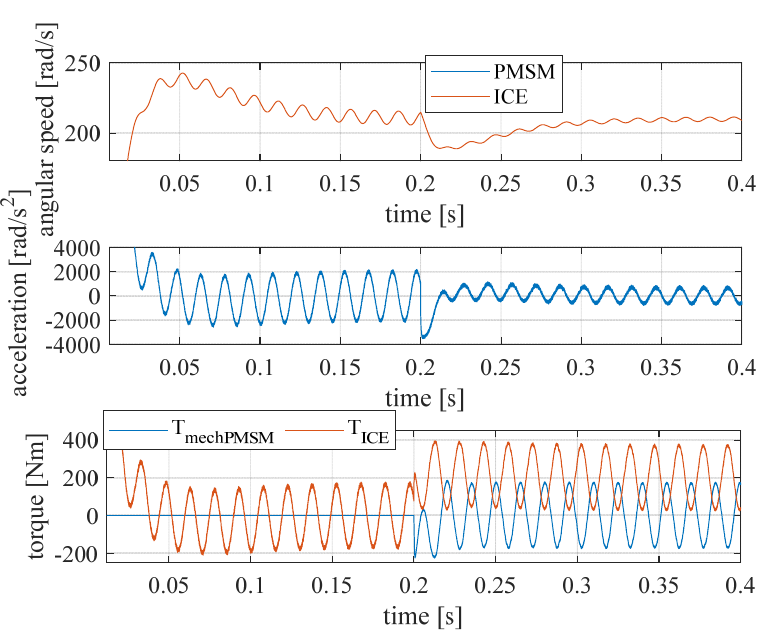
Figure 14. Speed, angular acceleration, and torques during compensation of ICE engine torque oscillations.